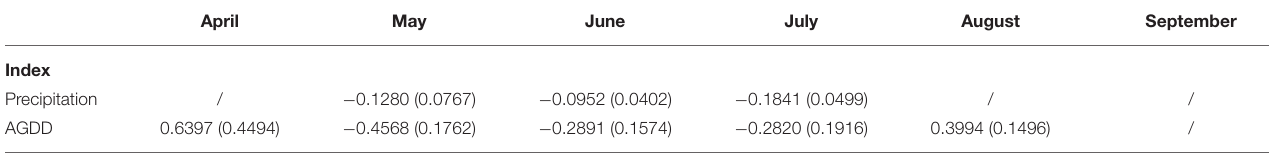
TABLE 2 | The simulation results are based on Model I.